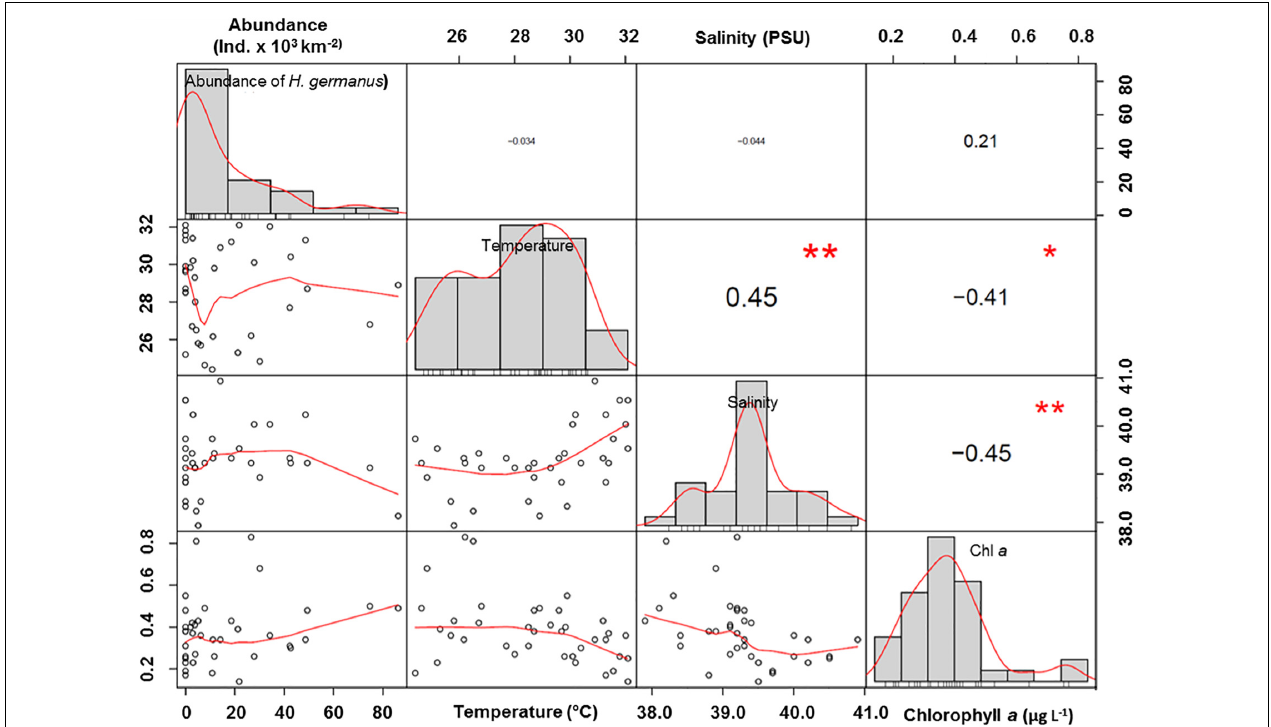
FIGURE 6 | Correlations of Halobates germanus abundance with environmental variables of temperature, salinity and chlorophyll a . The distribution of each variable is shown on the diagonal. Bivariate scatter plots with a fitted line show the relationship between the two variables. Values are Pearson’s correlation co-efficient. Bold values show maximal correlation. ∗ p < 0.05; ∗∗ p < 0.01; ∗∗∗ p < 0.001.